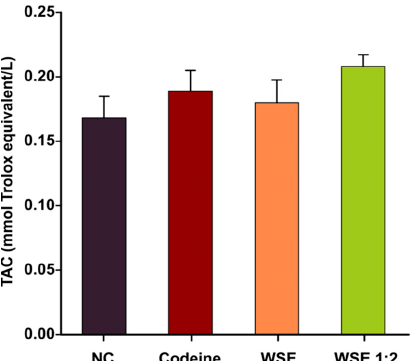
Figure 3. The effects of the treatments on total antioxidant capacity (TAC) in serum. Values are expressed as mean ± SEM ( n = 6). Statistical significance differences in datasets were determined with one-way ANOVA with the Holm-Sidak post hoc test. NC—negative control; WSE—walnut